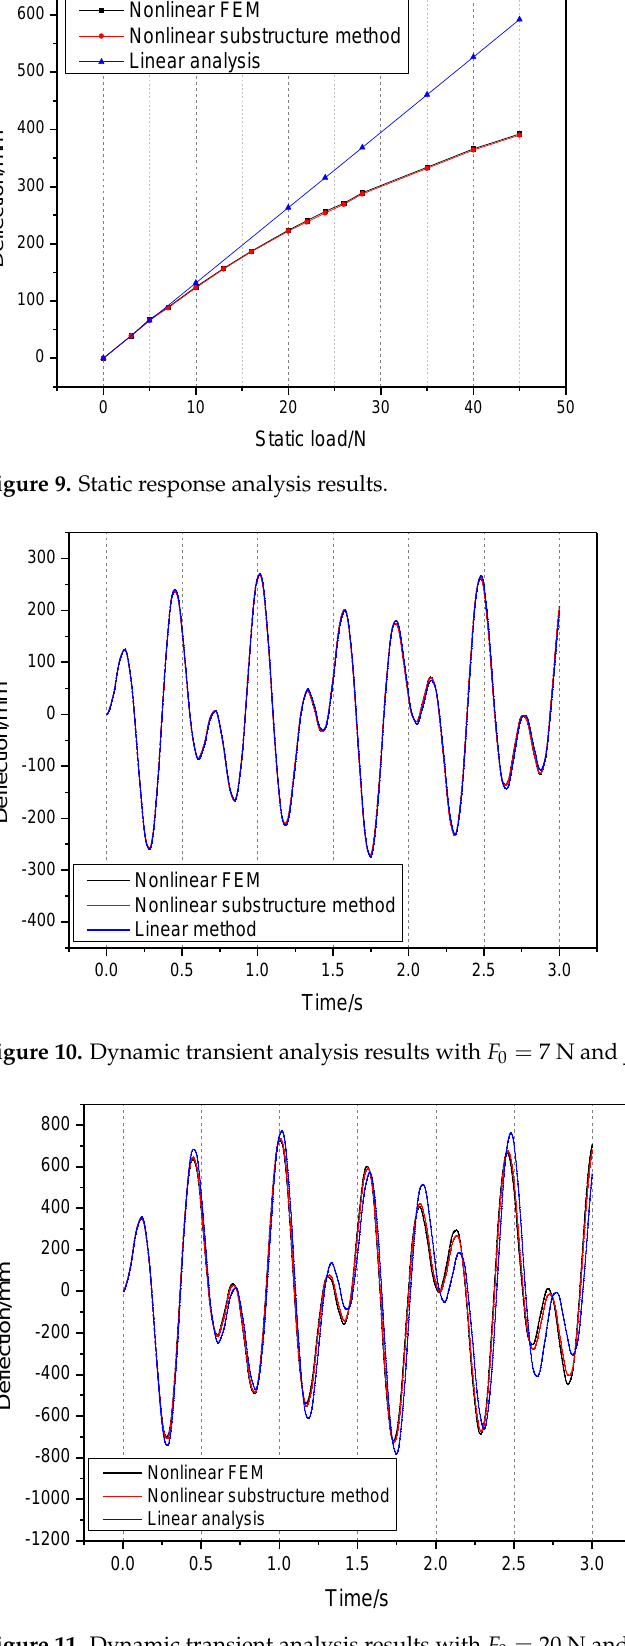
Figure 11. Dynamic transient analysis results with